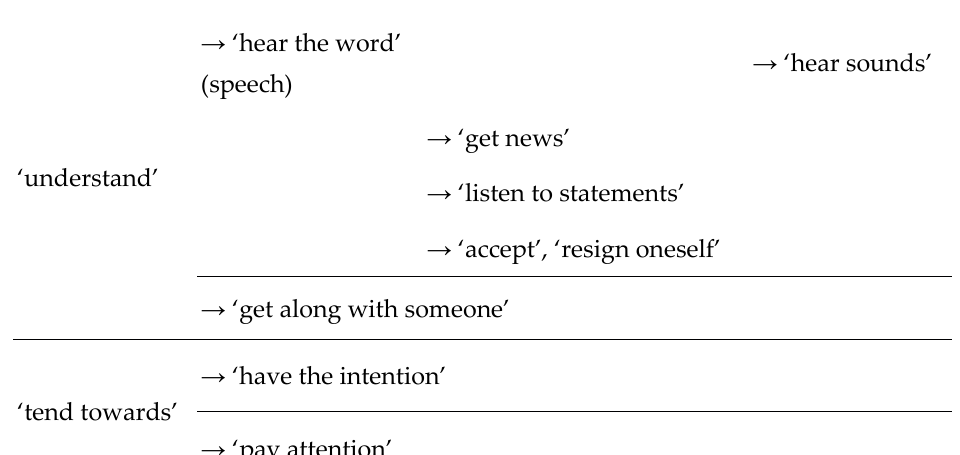
Figure 1. Diachronic semantic evolution of the verb sentir (Catalan).